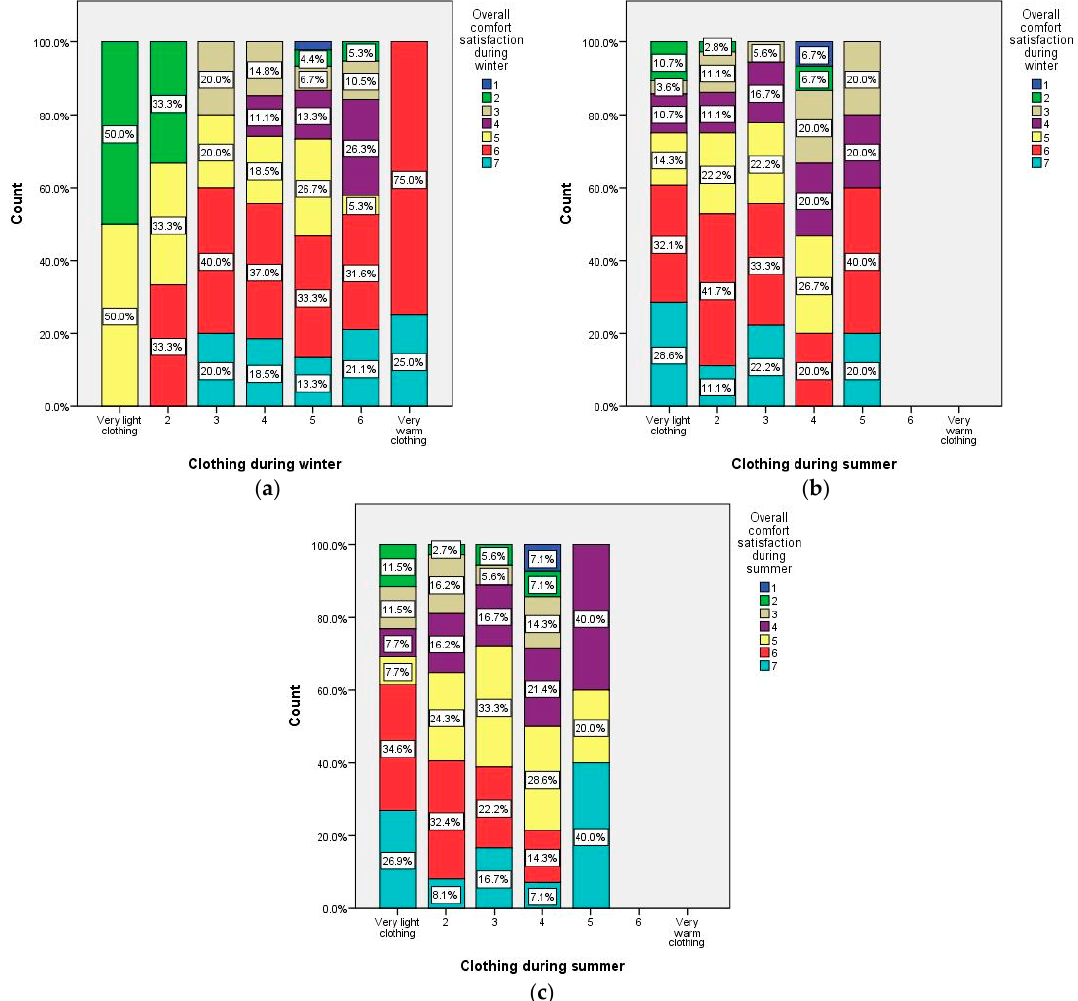
Figure 16. Relation between the overall comfort satisfaction during winter and the clothing choices of the occupants during ( a ) winter and ( b ) summer and ( c ) relation among the overall comfort satisfaction during summer and the clothing choices of the occupants during summer.